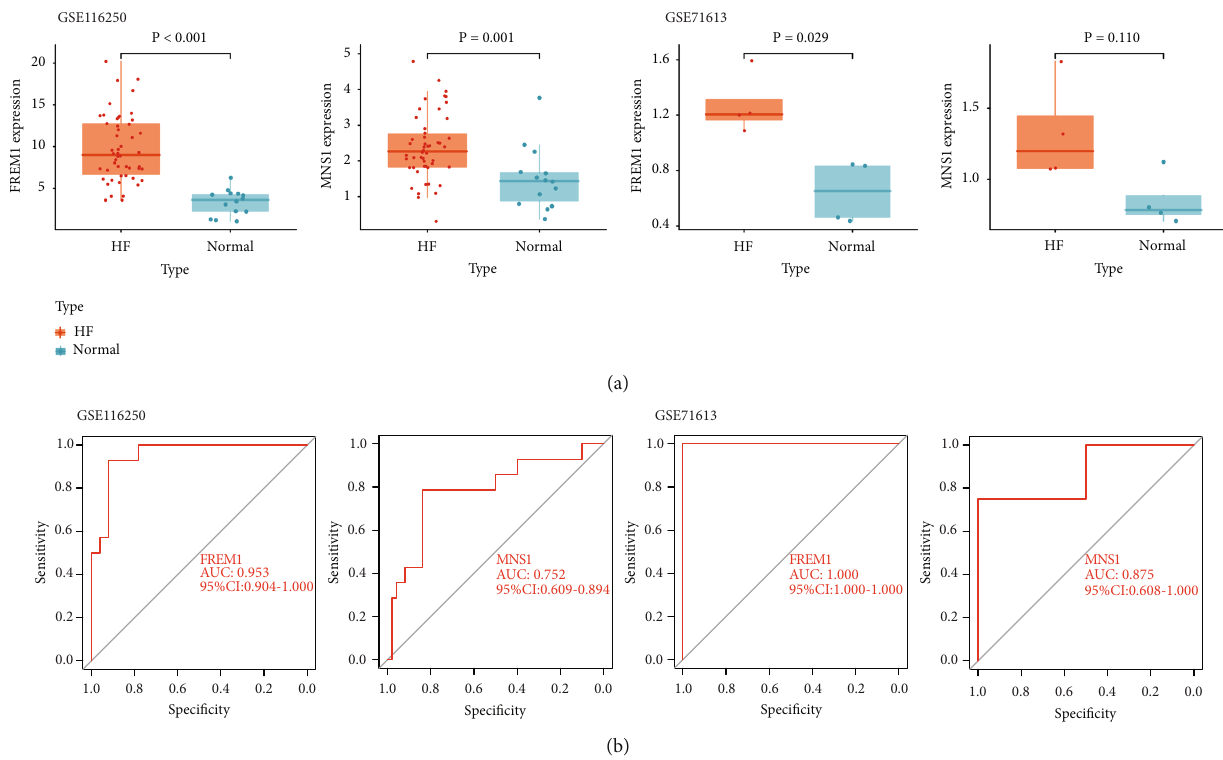
Figure 4: External RNA-seq dataset veri fi cation. (a) Gene expression levels of FREM1 and MNS1 . The red dots represent the HF samples, and the blue dots represent the normal samples; (b) ROC curve of FREM1 and MNS1 . The AUC values and 95% CI of FREM1 and MNS1 are marked in the fi